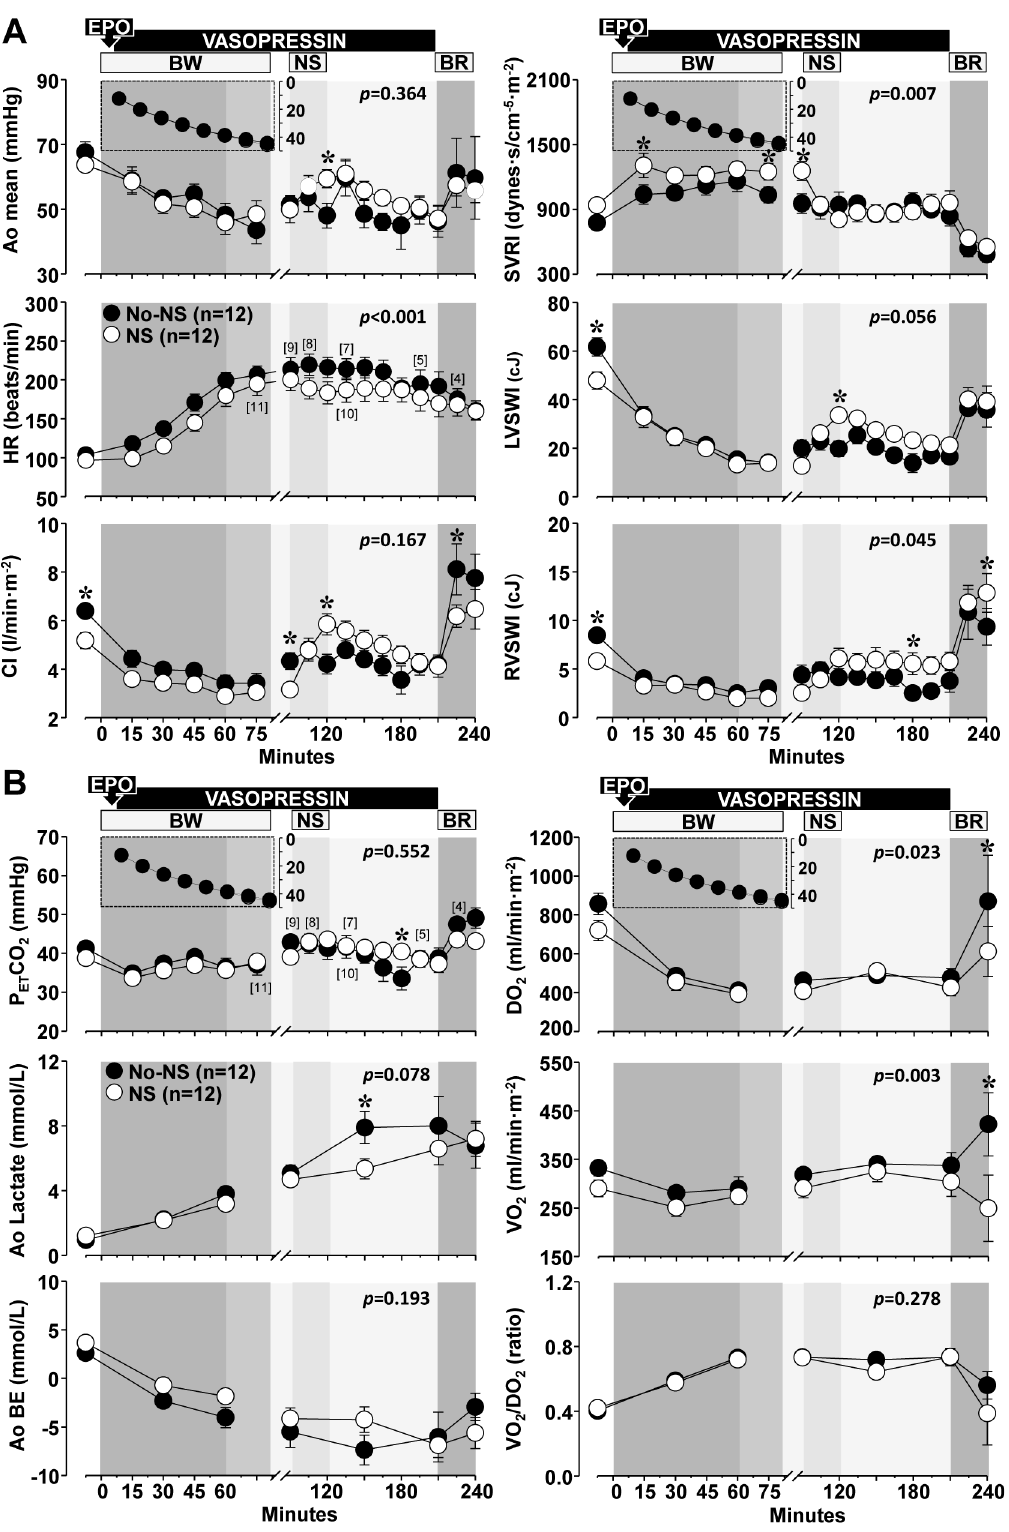
Fig 4. Effects of normal saline on hemodynamic and metabolic function during hemorrhagic shock. EPO, erythropoietin; BW, blood withdrawal; NS, normal saline; BR, blood reinfusion. The inset depicts the time course of the blood withdrawal (ml/kg) ending at 60 minutes in the 65% BW subset and at